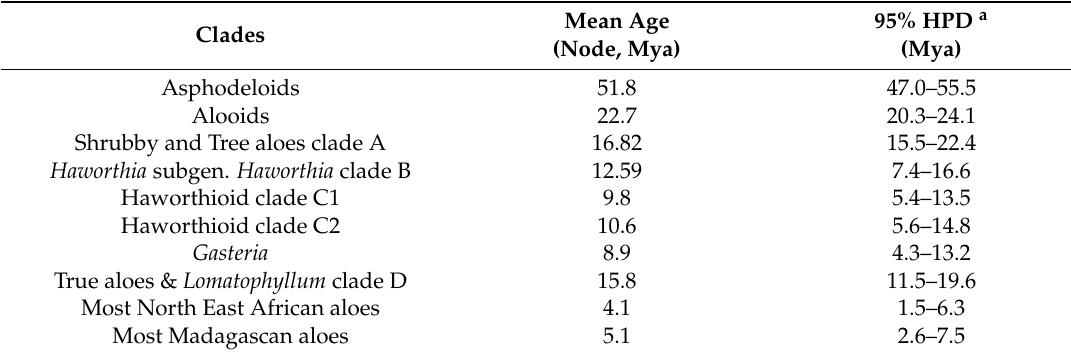
Table 2. Node age with the posterior probability densities are shown for important clades and outgroups